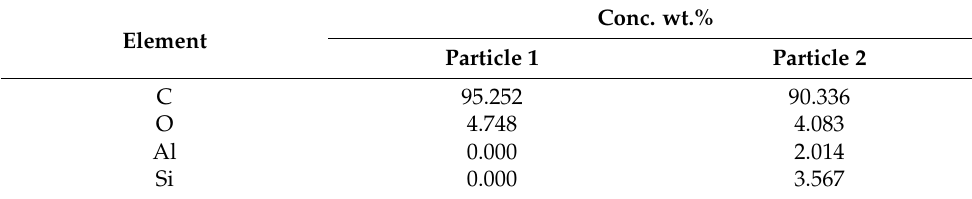
Figure 6. SEM image of flotation-cleaned coal. Table 5. EDS analysis results of flotation-cleaned coal surface.